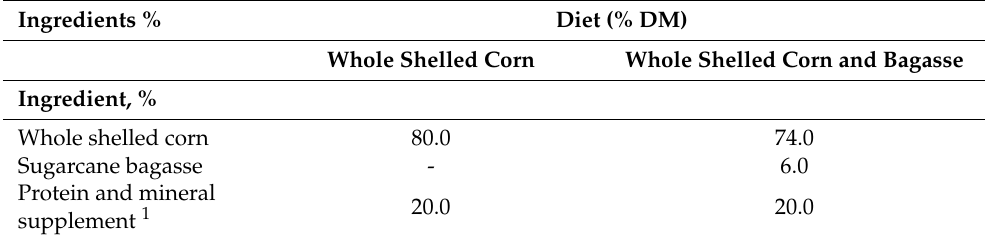
Table 1. Percentage of ingredients and chemical composition of experimental